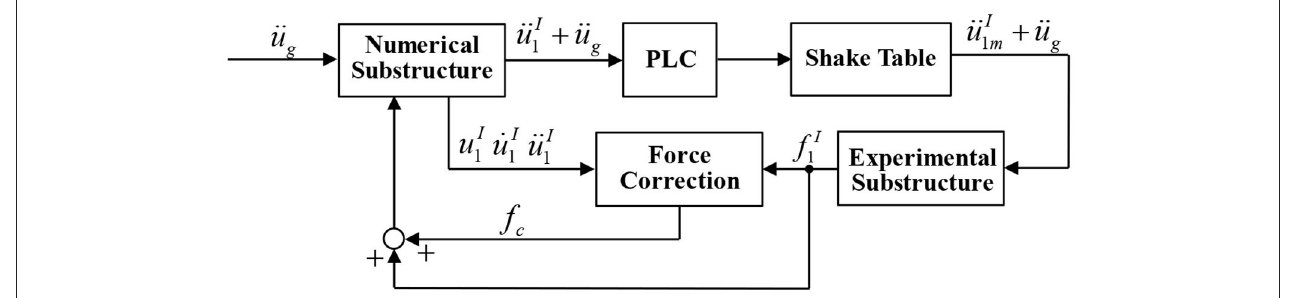
FIGURE 12 | Block diagram of the RTHS for the simplified BMD system.